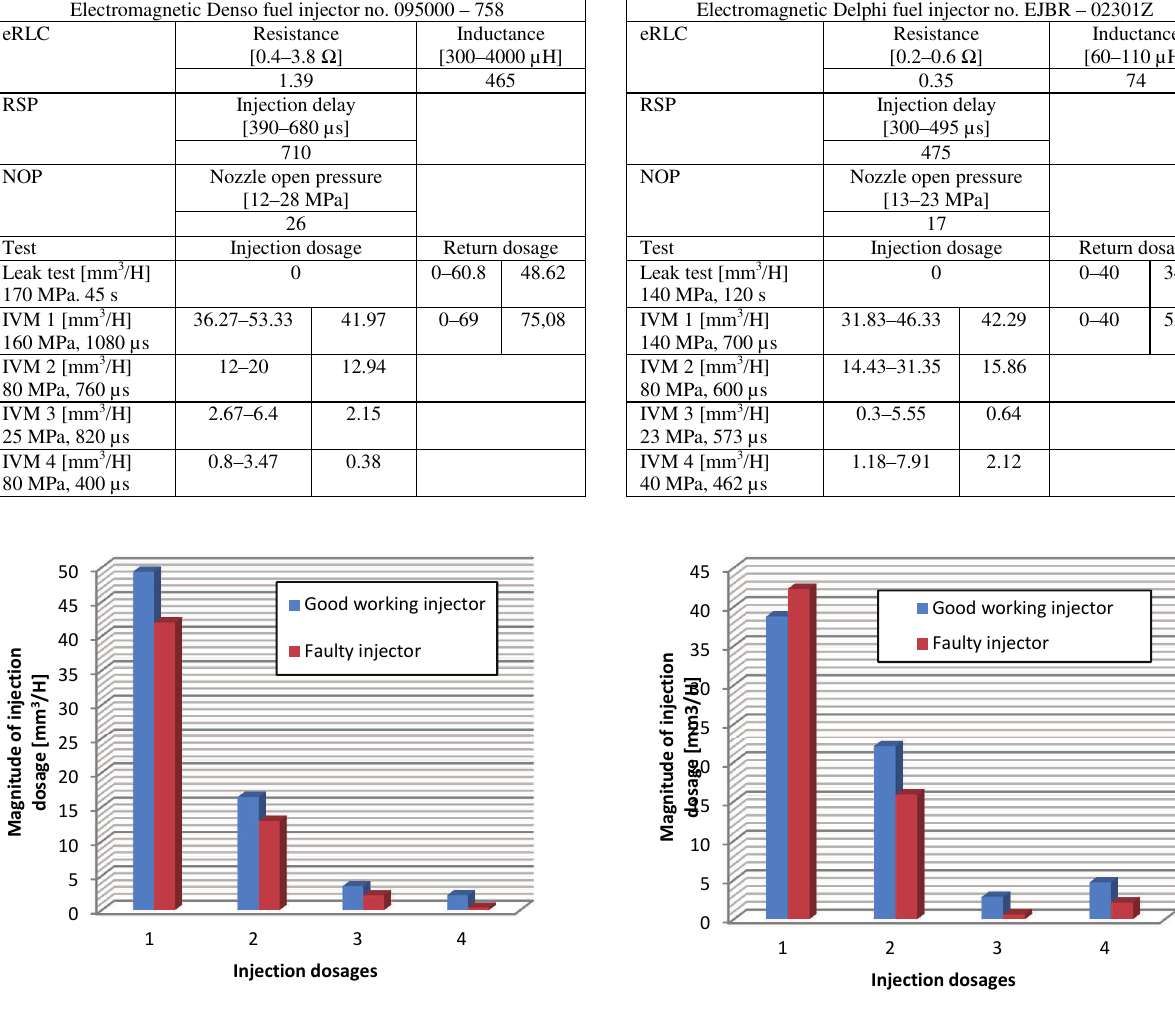
Fig. 14. Injection dosages comparison between faultless and faulty elec- tromagnetic Denso fuel injector 1 – full load dosage, 2 – medium load dosage, 3 – idle speed dosage, 4 – initial dosage